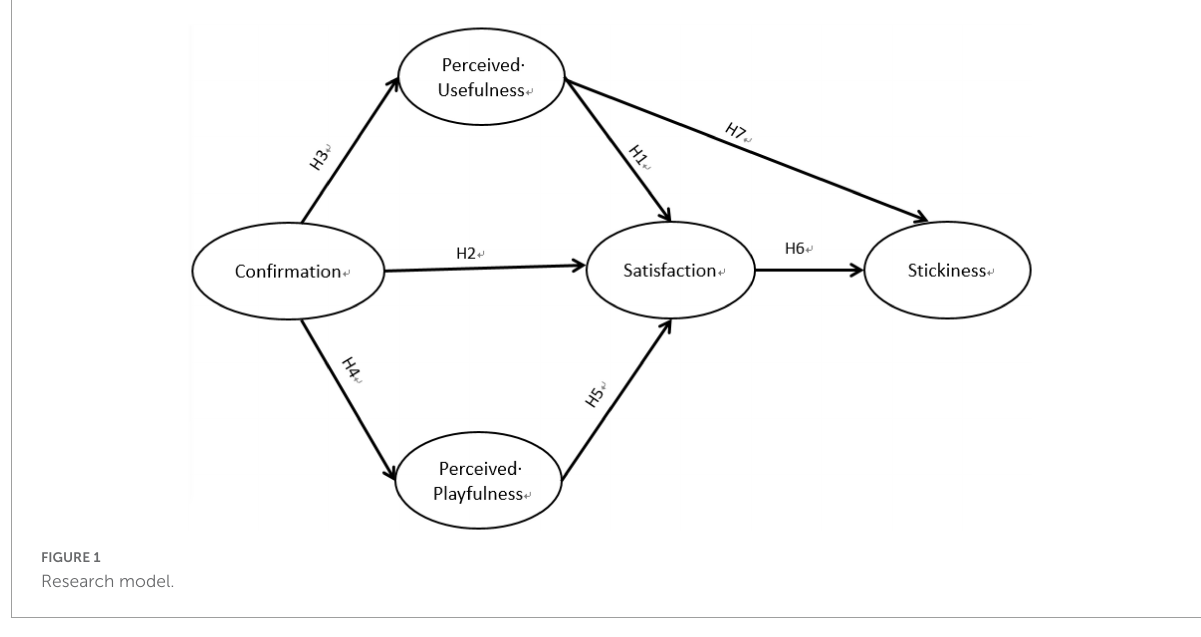
TABLE 1 Operational